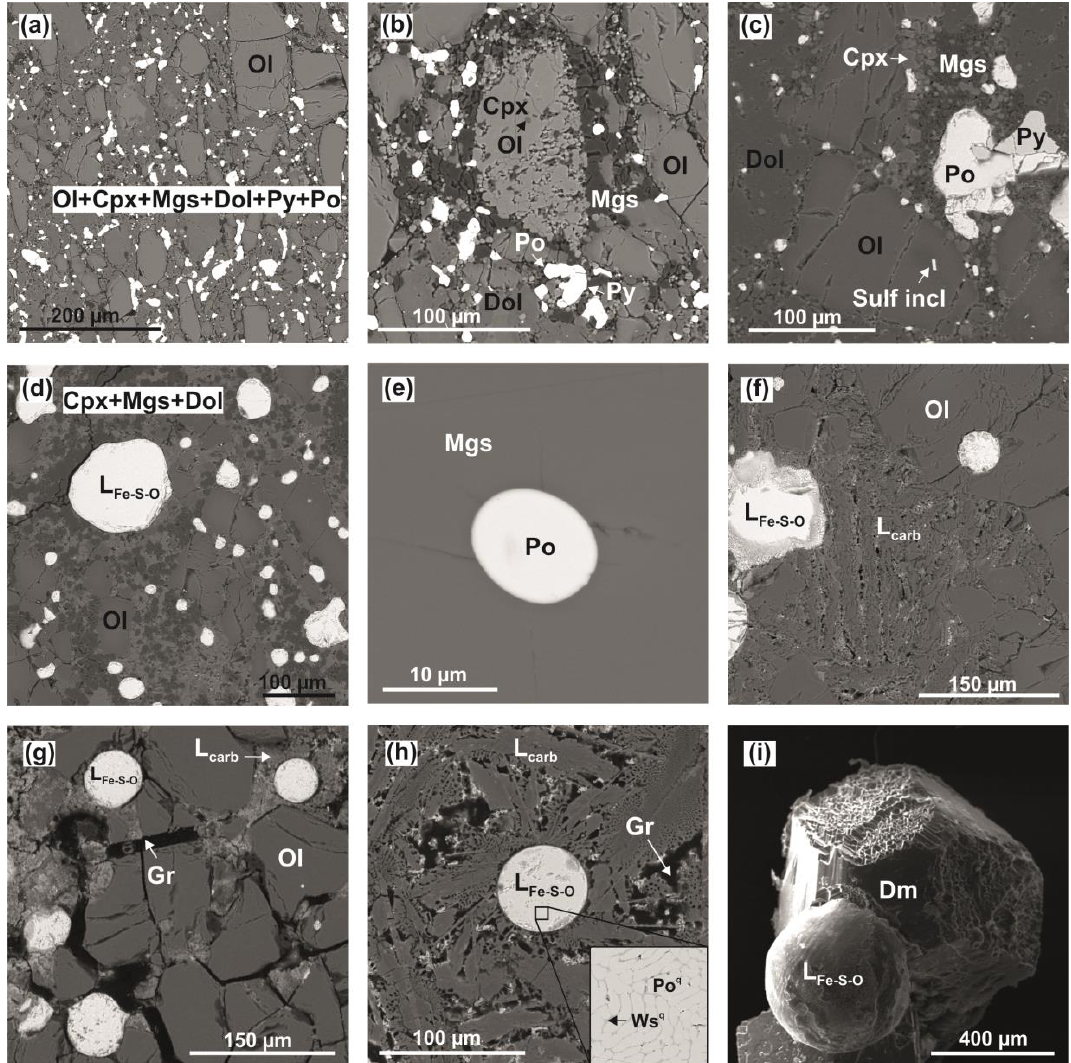
Figure 6. SEM micrographs of polished fragments of samples ( a – h ) and diamond seeds ( i ), which were obtained in the ankerite-olivine-pyrite system: ( a , b )—polycrystalline olivine aggregate with fine-crystalline olivine as well as newly formed clinopyroxene, magnesite, dolomite, pyrite, and pyrrhotite in interstices (1050 °C); ( c )—coarse-crystalline olivine and dolomite aggregate with fine-crystalline clinopyroxene, magnesite, pyrite, and pyrrhotite in interstices (1250 °C); ( d )—Fe-S-O melt droplets in a polycrystalline aggregate of olivine, clinopyroxene, dolomite, and magnesite (1350 °C); ( e )—pyrrhotite inclusion in magnesite (1350 °C); ( f )—recrystallized olivine in a carbonate-silicate melt, as well as Fe-S-O melt droplets (1450 °C); ( g )—droplets of a quenched Fe-S-O melt in a polycrystalline aggregate of olivine and graphite (1550 °C); ( h )—droplet of a quenched Fe-S-O melt in a carbonate-silicate melt (1550 °C); ( i )—diamond seed crystals with an overgrown layer and microspheres of a quenched Fe-S-O melt (1550 °C); Ol—olivine, Cpx—clinopyroxene, Py—pyrite, Mgs—magnesite, Arg—aragonite, Dol—dolomite, Gr—graphite, L Fe-S-O —sulfide melt with dissolved oxygen, L carb —carbonate melt, Sulf incl—sulfide inclusions in olivine;.